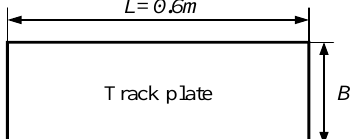
( b ) Figure 17. ( a ) Pressure-sinkage curves and ( b ) maximum sinkage under different conditions at 100 kPa case.